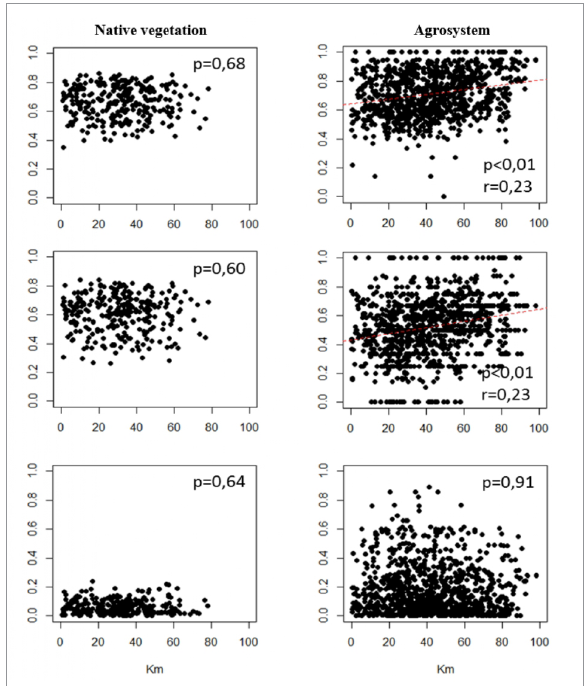
Figure 12: Relationship between ant fauna dissimilarity ( β sor, β sim, and β nes) and the distance between the locations of native vegetation and agrosystems. Pearson’s correlation (r) and the significance computed using Mantel’s analysis are displayed within the graphs. The points correspond to the comparison values between the sampling